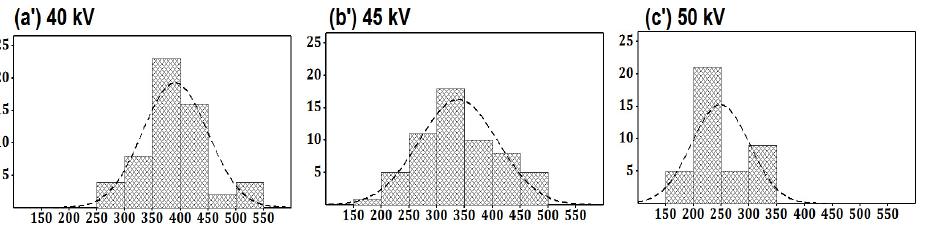
Figure 5. Histogram of diameter distribution at a different voltage with a constant concentration of 20% at a spinning distance of 20 cm.